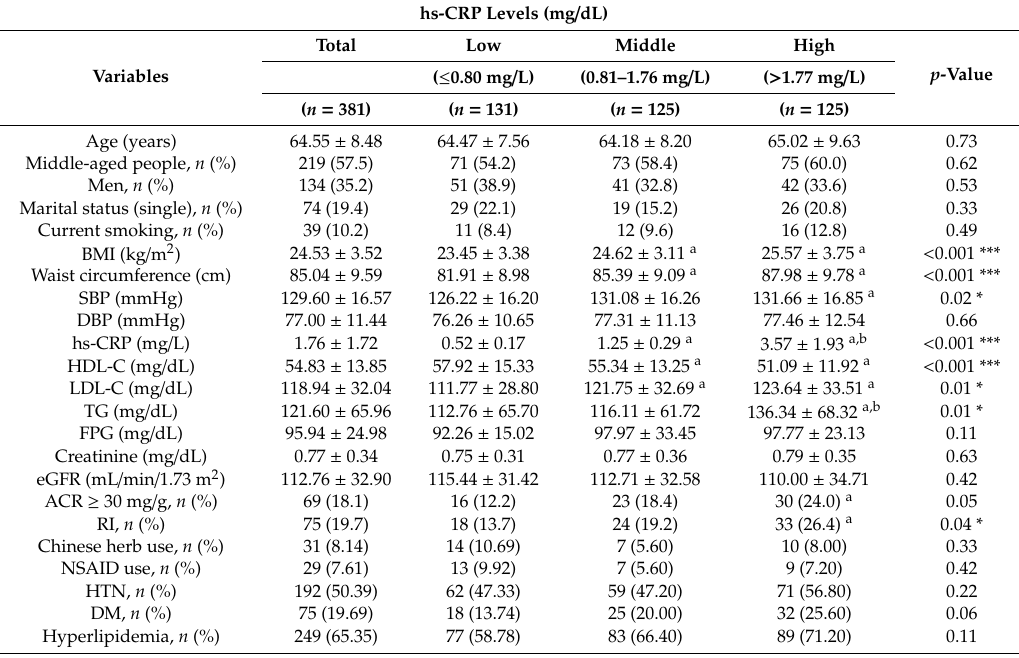
Table 1. General characteristics of the study population according to tertiles of hs-CRP